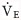
Cross validation results for Model D2: V˙E = e-8.57HR1.72fB0.611age0.298sex-0.206FVC0.614, where HR is beats per minute, fB is breaths per minute, age is in years, FVC is the GLI predicted value expressed in liters, and sex is 1 for males and 2 for females.The median(IQR) percent error from cross validation for this model is 1.20(37.9)%. Circles are persons without an FVC measurement; triangles are persons with measured FVC = 85–115% of the predicted value; diamonds are persons with measured FVC < 85% predicted, and squares are persons with measured FVC > 115% predicted. Dashed lines are ±25% error.